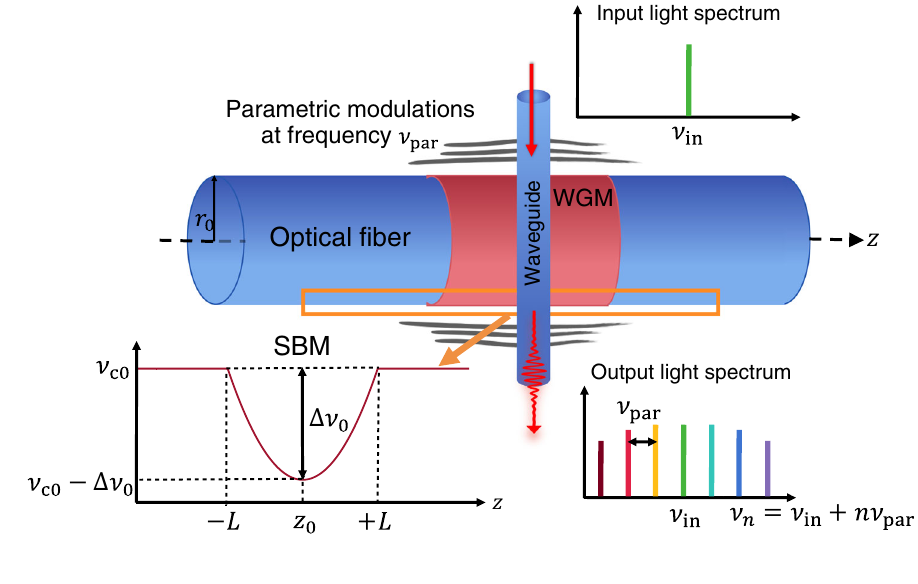
Fig. 1 Illustration of the considered system. A SNAP bottle microresonator (SBM) with parabolic cutoff frequency variation (CFV) centred at z 0 ¼ 0 introduced at the surface of an optical fi bre with radius r 0 . The SBM is coupled to the transverse waveguide that pumps light at frequency ν in and excites whispering gallery modes (WGMs). The SBM is parametrically modulated with frequency ν par and generates an optical frequency comb at the output of the waveguide with the repetition rate ν par.